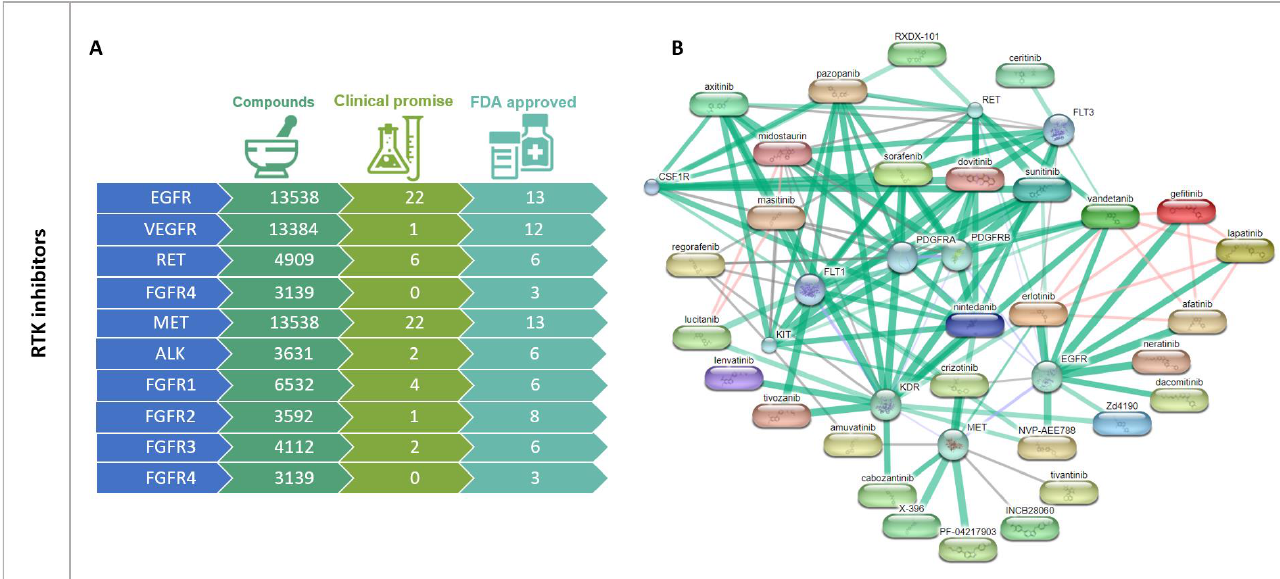
Figure 5. ( A ) Schematic illustrations of RTK druggability identified by the CanSAR database, including the total number of compounds with predicted interaction capacity with each kinase, as well as FDA-approved drugs and clinical candidates. ( B ) Interaction networks of RTK inhibitors and associated binding proteins according to STITCH (search tool for known and predicted interactions between chemicals and proteins available at http://stitch.embl.de (accessed on 1 November 2022)). Compounds are represented as pill-shaped nodes, while proteins are shown as spheres. Small nodes represent proteins of unknown 3D structures, while large nodes show proteins with known or predicted structures. Nodes that are associated with each other are linked by an edge: thicker lines represent stronger binding affinities. Networks were constructed considering a minimum required interaction score of 0.700, and based on associations reported in curated databases (gray lines), or on both databases and experimental/biochemical data (green lines). Purple lines represent functional links between proteins.